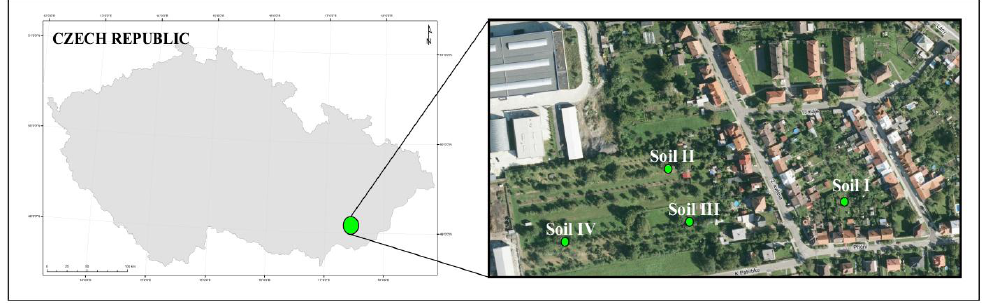
Figure 2. Sampling site location ( Soil I: 49 ◦ 09 (cid:48) 41.9 (cid:48)(cid:48) N, 17 ◦ 30 (cid:48) 59.0 (cid:48)(cid:48) E; Soil II: 49 ◦ 09 (cid:48) 42.8 (cid:48)(cid:48) N, 17 ◦ 30 (cid:48) 50.3 (cid:48)(cid:48) E; Soil III: 49 ◦ 09 (cid:48) 40.9 (cid:48)(cid:48) N, 17 ◦ 30 (cid:48) 51.8 (cid:48)(cid:48) E; Soil IV: 49 ◦ 09 (cid:48) 40.7 (cid:48)(cid:48) N, 17 ◦ 30 (cid:48) 45.9 (cid:48)(cid:48) N).